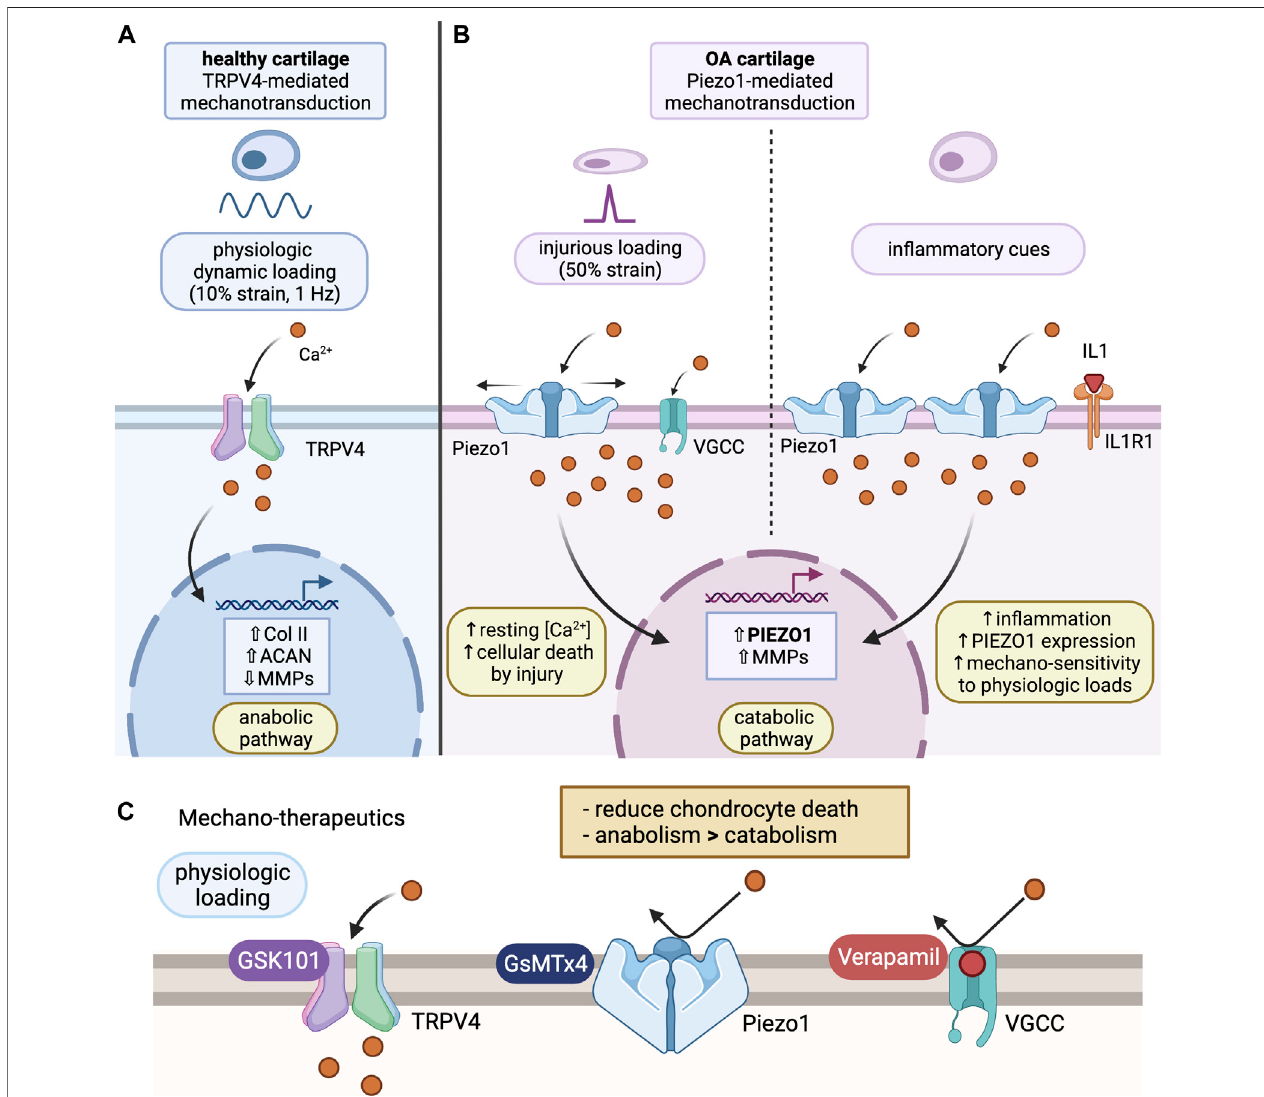
FIGURE 1 | Chondrocyte mechanotransduction and potential mechano-therapeutics. (A) TRPV4-mediated Mechanotransduction of Healthy Cartilage: under physiologicalloading(10%strain),Ca 2+ ionsenterthroughactivatedTRPV4channelandpromoteananabolicpathway.ThisleadstoincreasedcollagenIIandaggrecan expression,aswellasreducedexpressionofMMPs.Ultimately,thispreventsdegradationofthecartilageECMandpromotessynthesisofimportantECMmolecules. (B) Piezo1-mediatedMechanotransductionofOAcartilage:underinjuriousloading(50%strain)orin fl ammatoryactivationviaIL-1 α ,Ca 2+ entersthecellthroughPiezo1 channels. Activation of Piezo1 channels also triggers voltage gated Ca 2+ channel opening, resulting in excess Ca 2+ concentrations in the chondrocyte, activating a catabolic pathway. This will result in enhanced PIEZO1 and MMP expression, increasing mechanosensitivity of chondrocytes to mechanical loading. (C) Proposed Mechano-therapeutics:GsMTx4,aninhibitorofPiezo1,preventsCa 2+ in fl uxinresponsetoPiezo1activationunderinjuriousloading,actingtoprotectthechondrocytes. Verapamil, a VGCC inhibitor, further regulates Ca 2+ homeostasis by preventing excess Ca 2+ in fl ux through VGCCs that activate in addition to Piezo1 channels under abnormal loading. GSK101, an agonist of TRPV4, mediates an anabolic phenotype, resulting in reduced expression of degradative enzymes, like MMP, and enhanced expression of cartilage ECM components, like collagen II and aggrecan. Combined, these therapeutics can be used to promote an anabolic pathway, decrease ECM degradation, and prevent progression of the cartilage into an OA phenotype. (Figure created using BioRender.com).